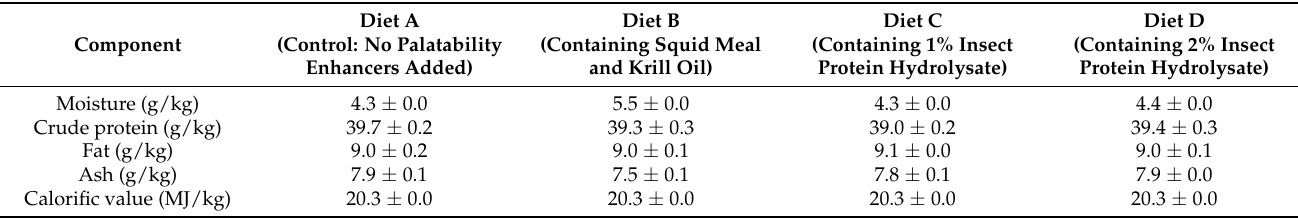
Table 1. Proximate composition of four diets used in this study. Component